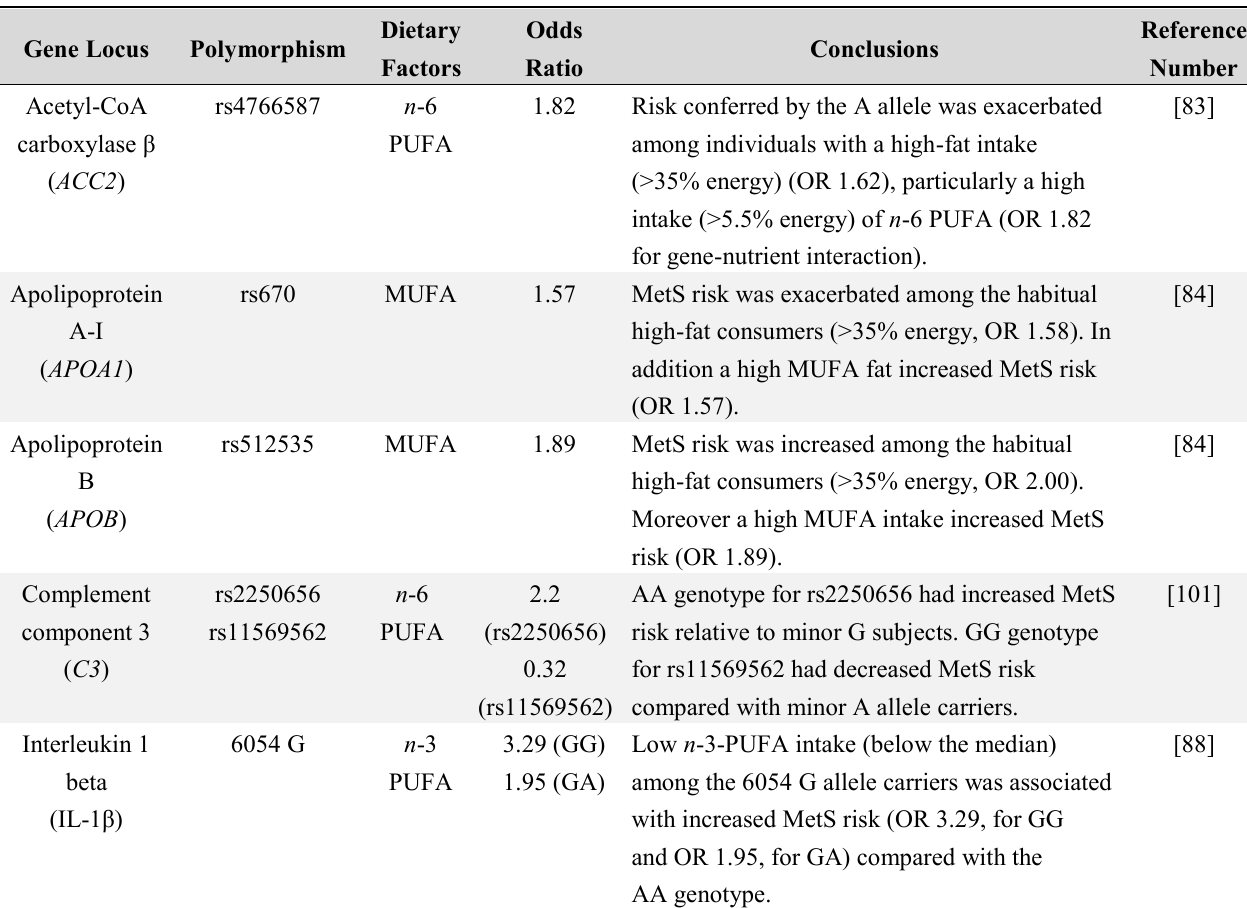
Table 1. Gene-nutrient interactions which modulate metabolic syndrome